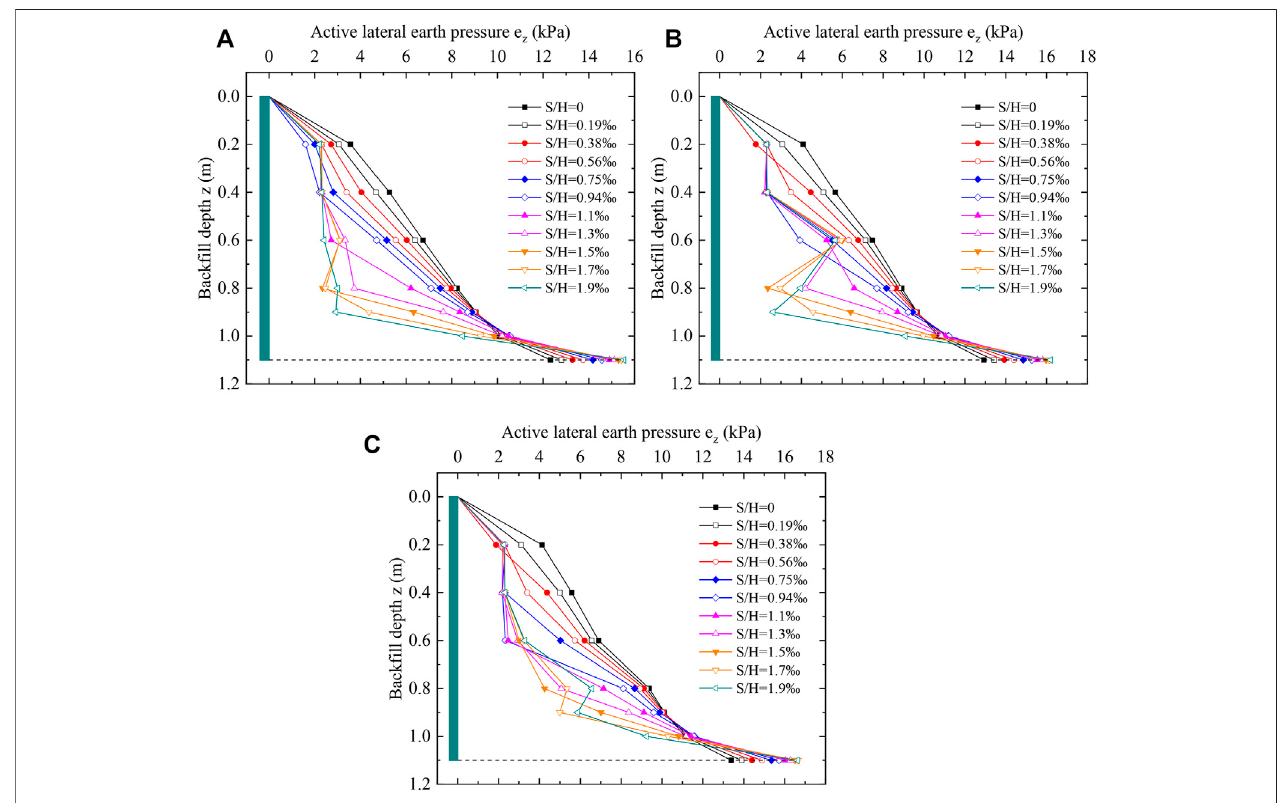
FIGURE 15 | Finite element modeling of active lateral earth pressure in the RB displacement mode of retaining walls. (A) β = 40 ° . (B) β = 50 ° . (C) β = 60 ° .